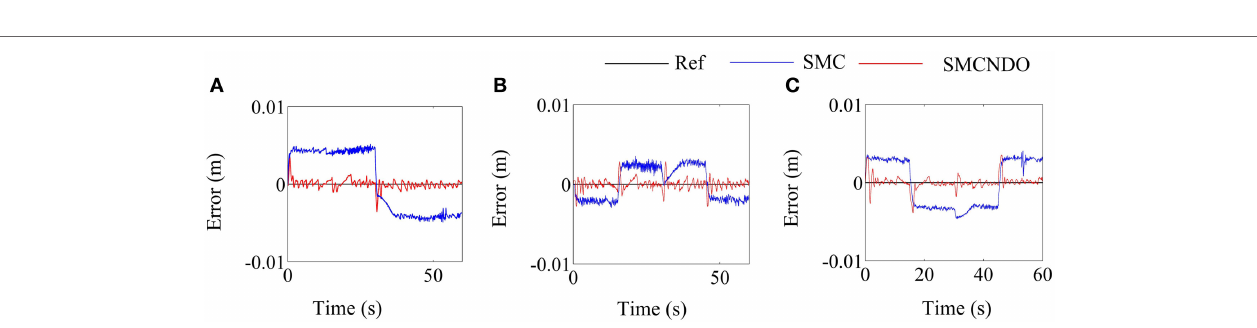
FIGURE 5 | Comparison of tracking errors in the three coordinate directions by implementation of sliding mode control (SMC) and sliding mode control with nonlinear disturbance observer (SMCNDO) when a healthy subject follows a square-shaped trajectory. (A) Tracking errors in the X direction by implementation of SMC and SMCNDO, (B) tracking errors in the Y direction by implementation of SMC and SMCNDO, and (C) tracking errors in the Z direction by implementation of SMC and SMCNDO.